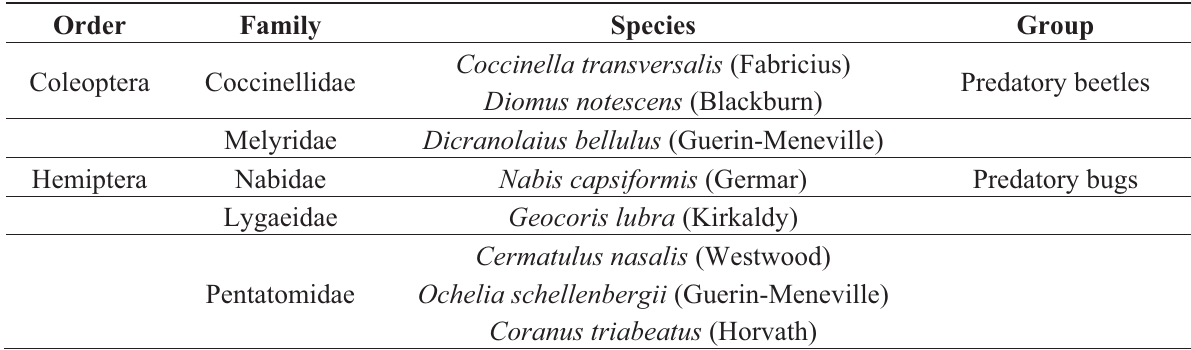
Table 2. Predators of cotton pests sampled and identified from the study sites in 2006 –